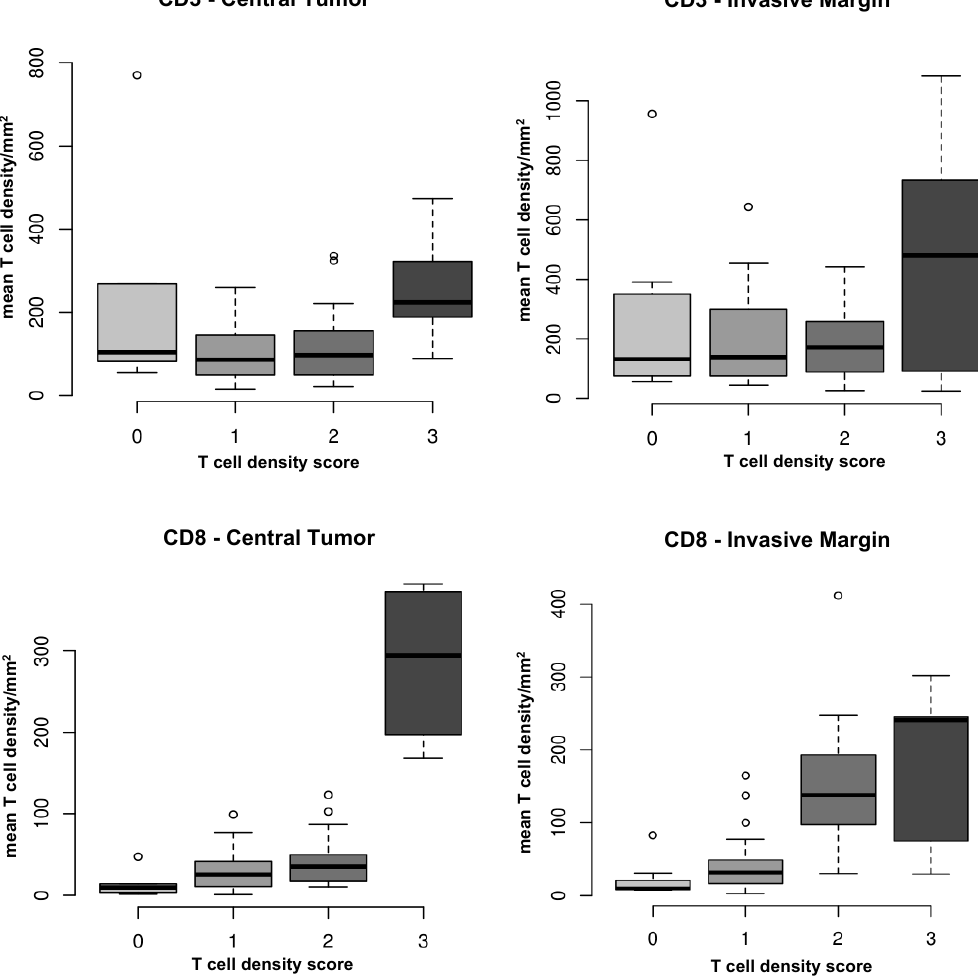
Figure 3. Correlative analysis of T cell densities quantified on full tissue sections (score 0–3) vs. mean T cell densities of 6 cores. T cell densities of the 2 quantification methods match with respect to correlational strength in the different tumor areas. Top : Tumoral and marginal CD3 positive T cells: R = 0.35 (medium correlation) and R = 0.14 (weak correlation), respectively. Bottom: Tumoral and marginal CD8 positive T cells: R = 0.45 (medium correlation) and R = 0.69 (good correlation), respectively. Note. Score: no (0), low (1), moderate (2) or high (3) protein levels with respect to positive T cells or TILs present; R—Spearman's correlation coefficient.